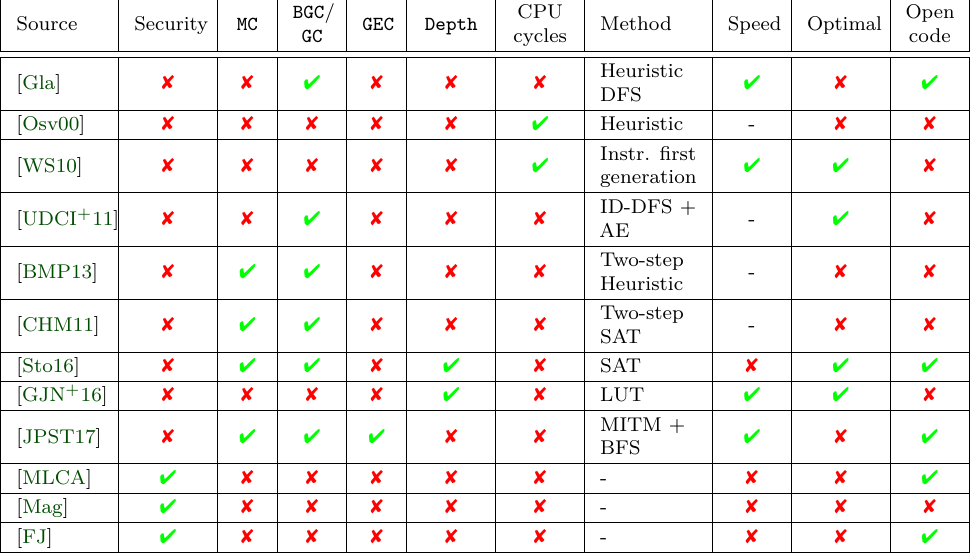
Table 5: Known tools on